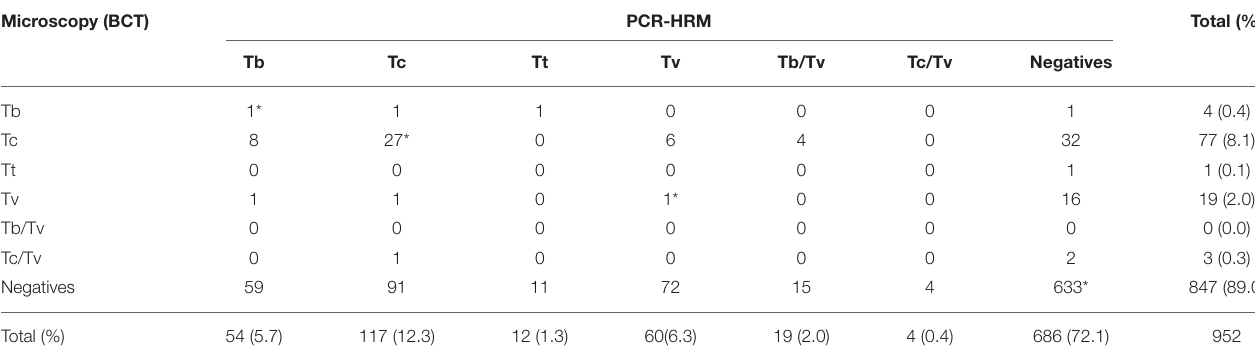
TABLE 2 | Comparison of diagnostic test results obtained by microscopic (BCT) and molecular method (PCR-HRM). Microscopy (BCT)